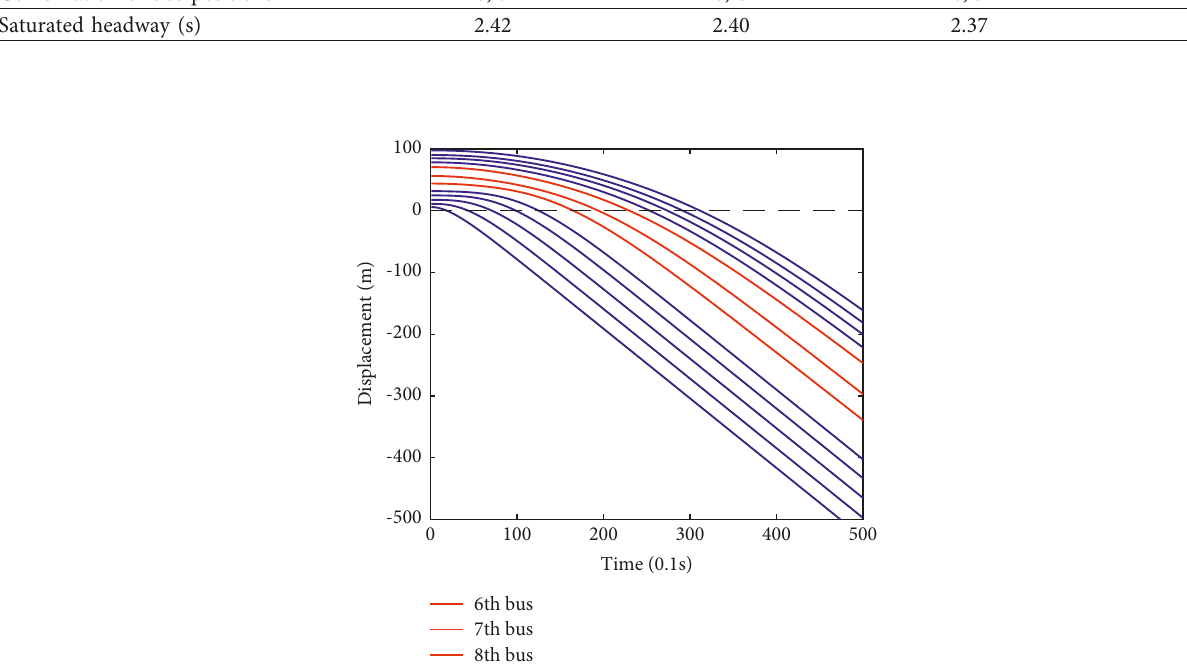
Figure 20: The numerical simulation diagram in 20–30% heavy vehicles